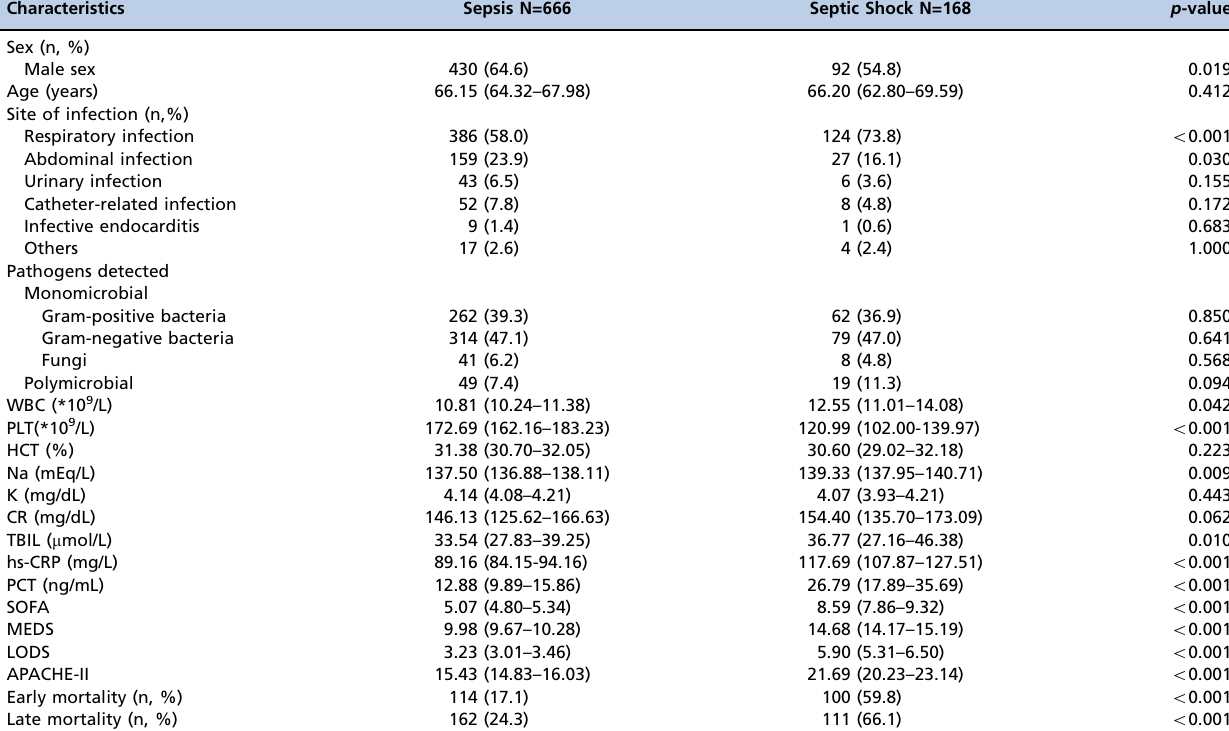
Table 1 - Comparison of the clinical and biological characteristics of patients with sepsis and septic shock. Characteristics